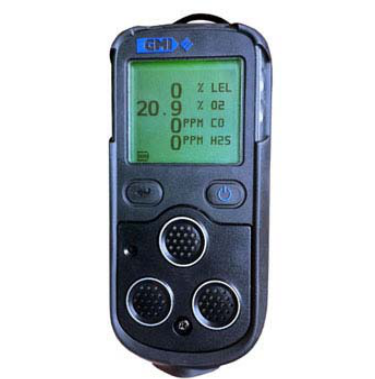
Figure 3 – Combustible gas detector PS200